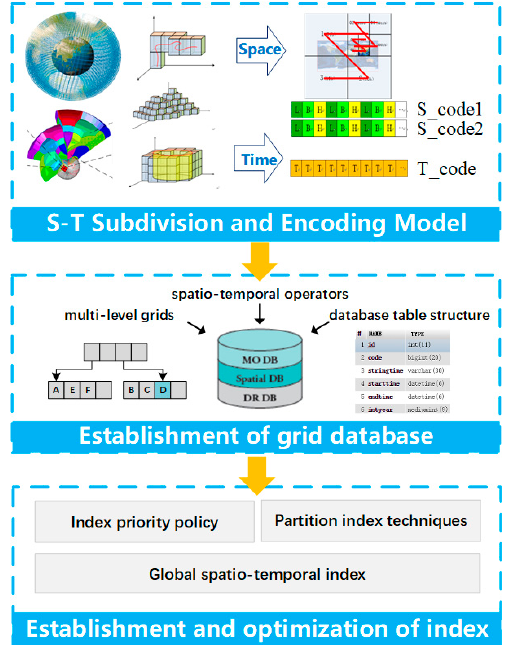
F igure 1 schematic diagram of different methods.